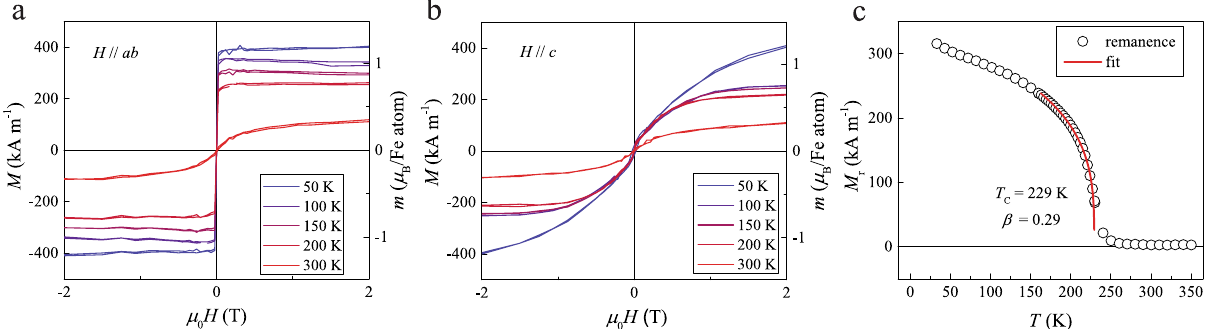
Fig. 5 Magnetic characterization of 2 nm-thick Fe 5 GeTe 2 . a Isothermal magnetic hysteresis loops with the external magnetic fi eld H in the ab basal plane for different temperatures. b Same as a , with external magnetic fi eld H parallel to the c -axis. c Remanent magnetization as a function of temperature. Fitting to the scaling behavior of a magnetic system in an ordered state yields T C ≈ 229 K and β ≈ 0.29. (see Supplementary Fig. 6 for a comparison with different 3D and 2D magnetic critical